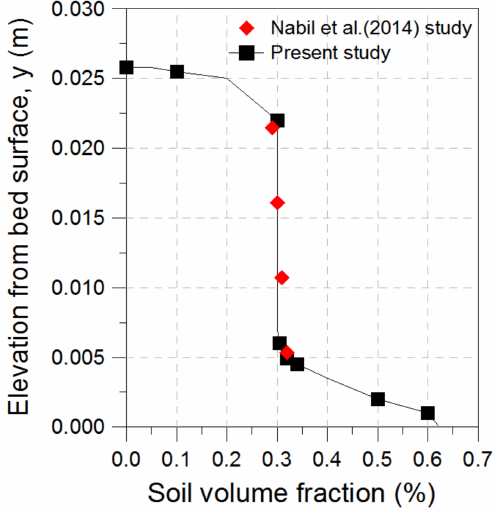
Figure 4. Comparison of the simulated soil volume fraction (%) with that in experimental results